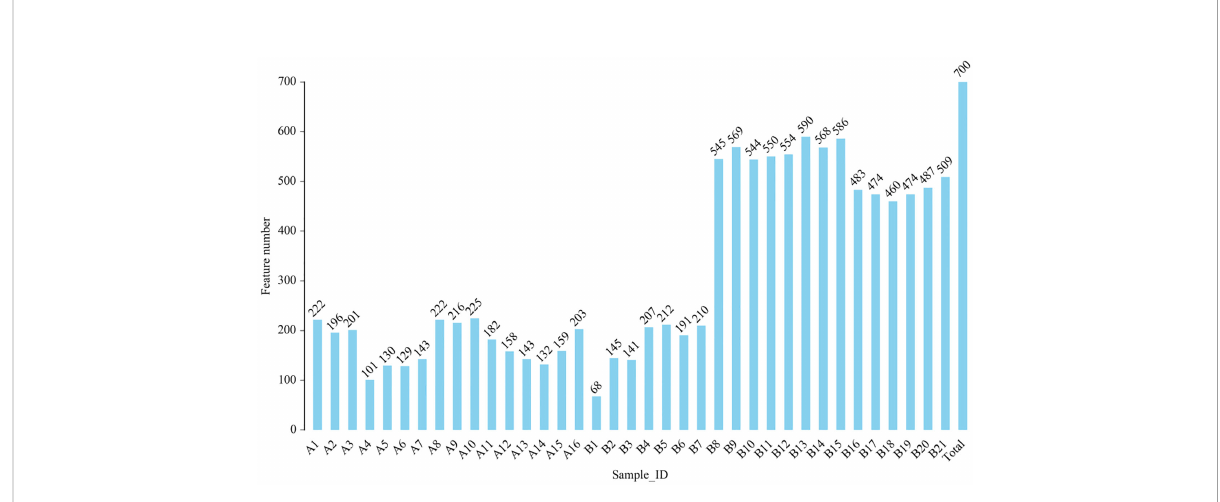
FIGURE 1 Comparison of operational taxonomic units (OTUs) in bronchoalveolar lavage fl uid (BALF) from lower respiratory tract infection (LRTI) children with/without hematological malignancies. P = 0.001, < 0.01, feature number of group A(A1-16) was obviously lower than that of group B(B1- 21) . A1 – 16 stand for the BALF samples of LRTI children with hematological malignancies, while B1 – 21 stand for the samples of LRTI children without malignancies.